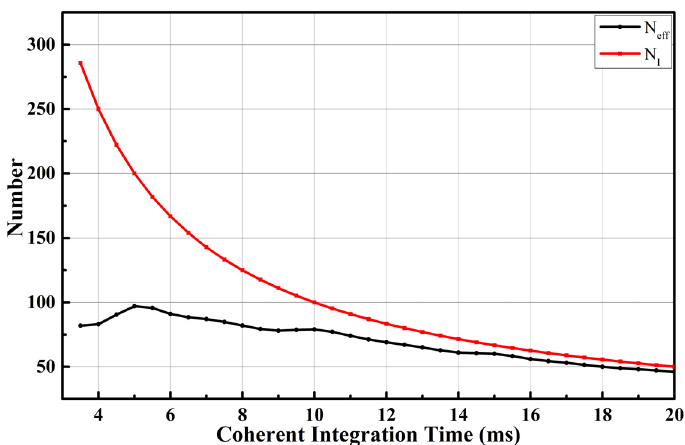
Figure 7. Comparison of the effective incoherent average number (black) and the incoherent average number (red).